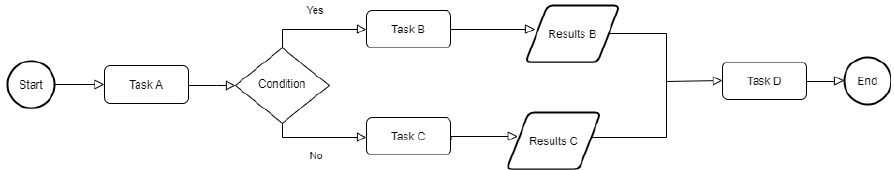
Figure 8. Flow diagram example with four tasks A , B , C , and D [1].